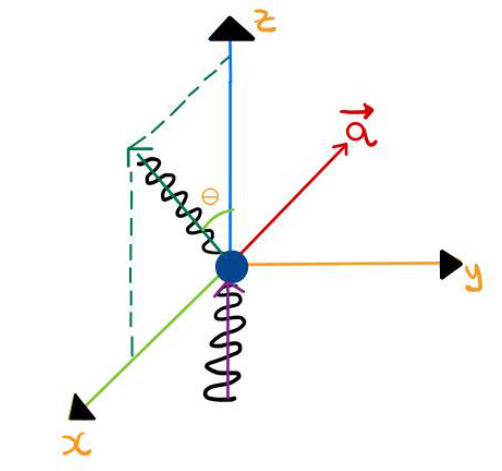
Figure 1. Wave scattering process in an Amplitude setup. An incoming plane wave traveling along the z -axis hits a BH at rest; the wave gets scattered with outgoing momentum lying in the x − z plane. We have introduced a spin vector ~a , oriented in a generic direction, in preparation for the process of wave scattering off Kerr BH, treated in section